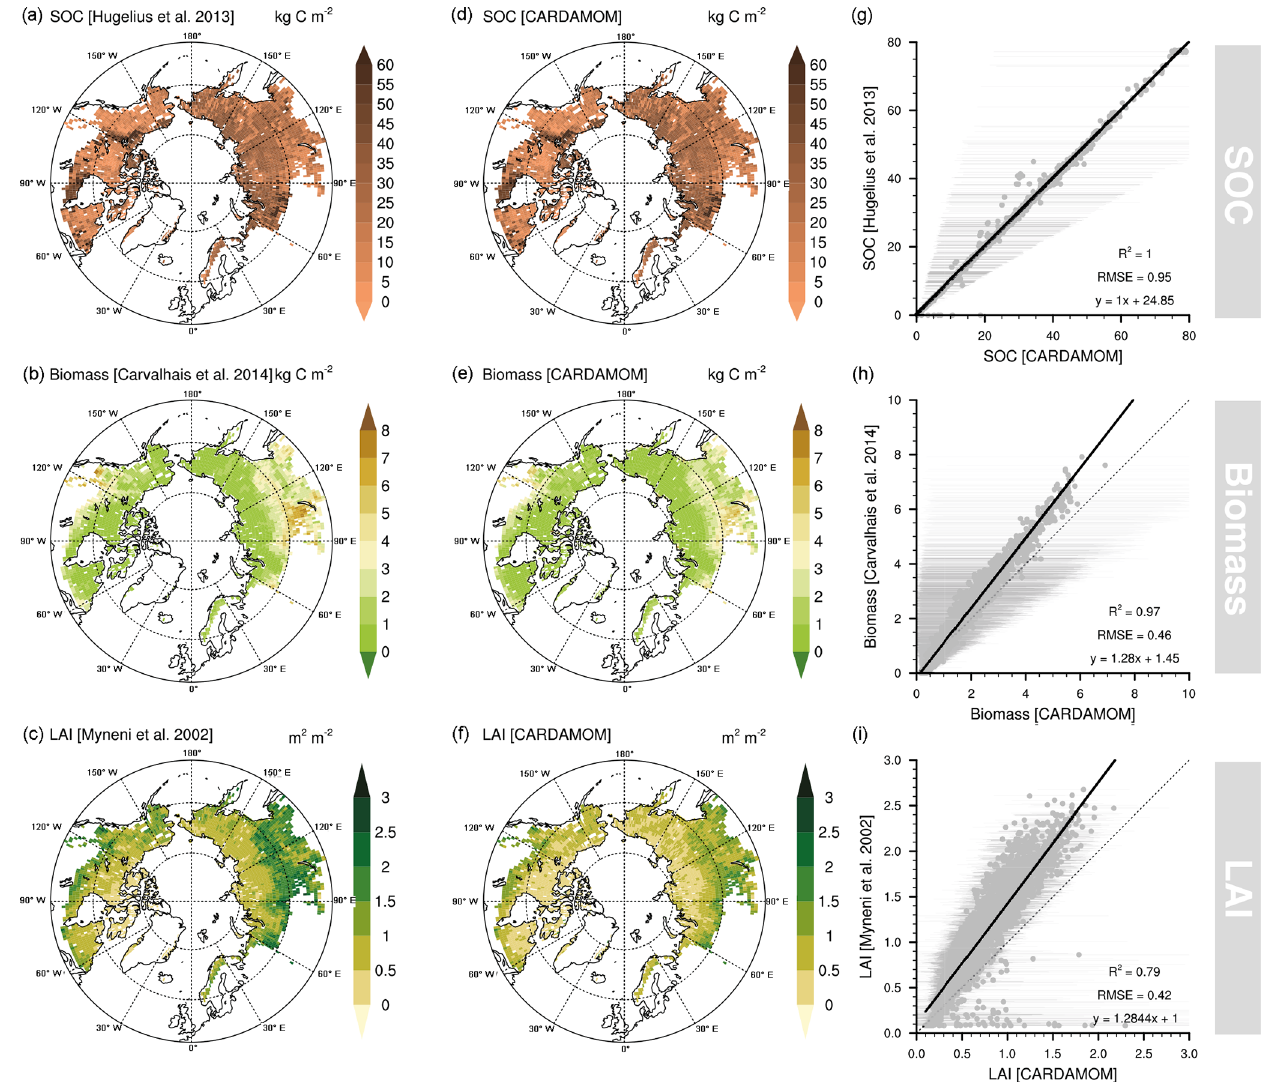
Figure 2. Original soil organic carbon (SOC; Hugelius et al., 2013a), biomass (Carvalhais et al., 2014), and leaf area index (LAI; Myneni et al., 2002) datasets used in the data-assimilation process within the CARDAMOM framework (a–c) , assimilated SOC, biomass, and LAI integrated into CARDAMOM (d–f) and their respective goodness-of-fit statistics between original and assimilated datasets (g–i) . The error bars represent the 90% confidence interval of the assimilated variable in